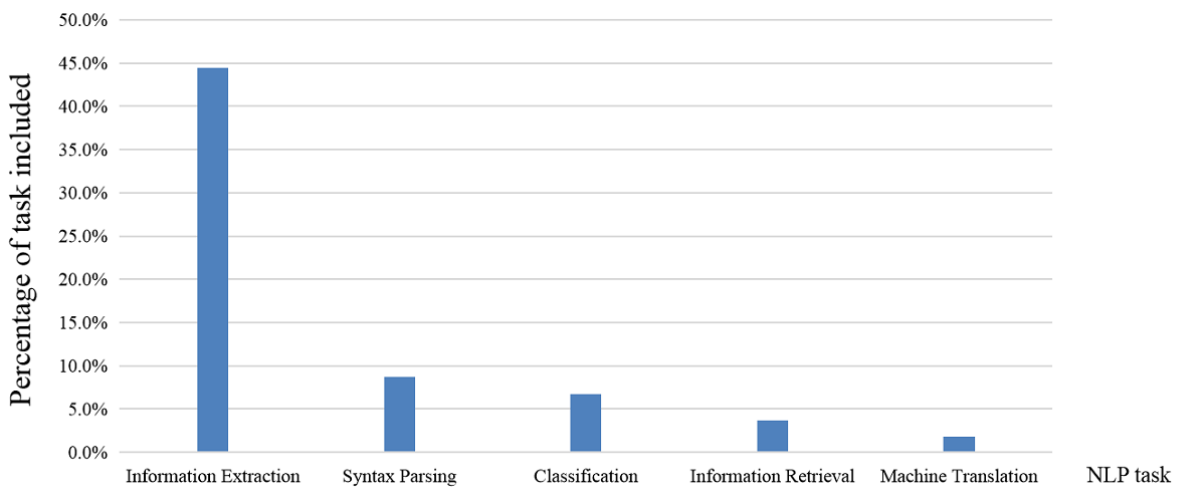
Figure 9. Top five ranks of the research tasks of natural language processing (NLP) in the medical